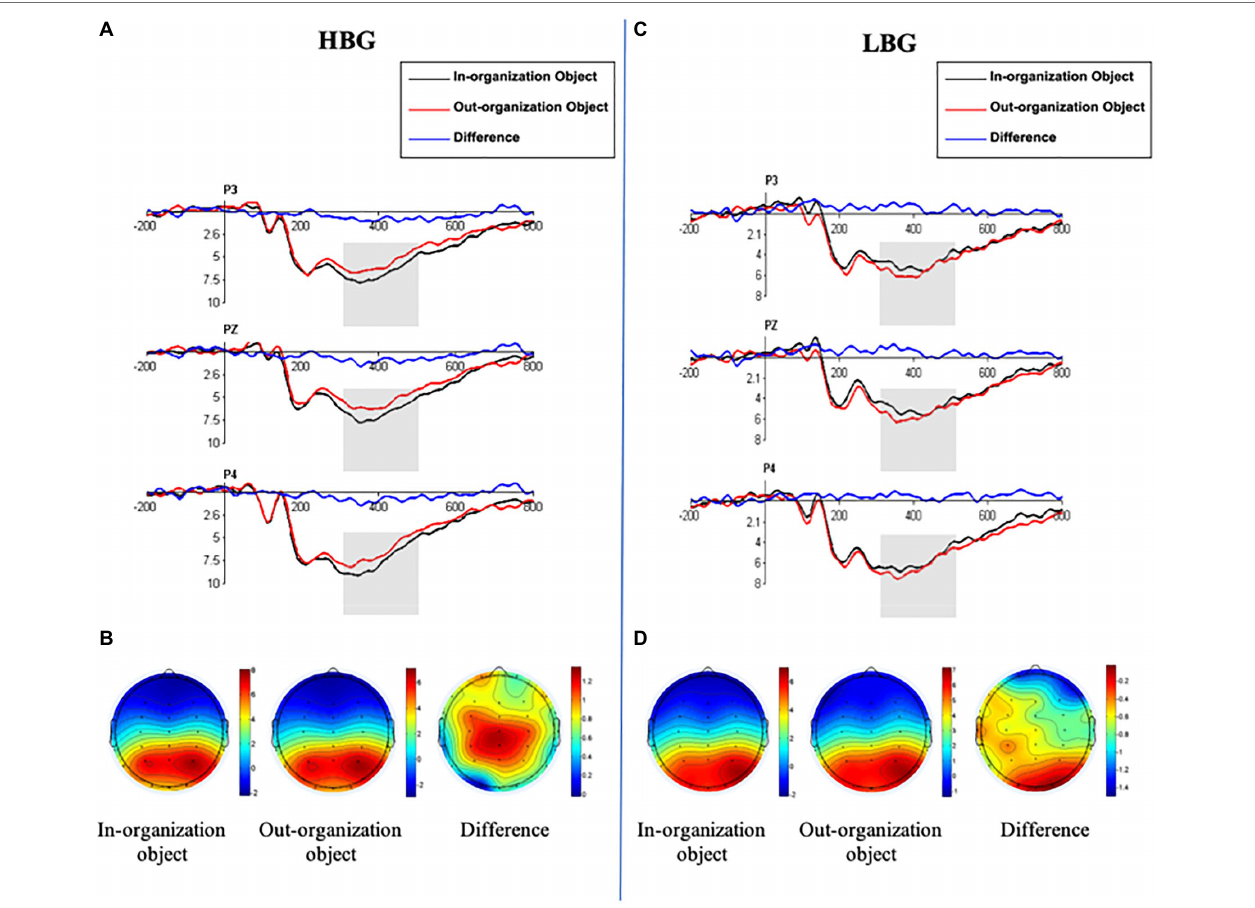
FIGURE 4 | Event-related potentials (ERP) results for Study 2. (A,C) The Grand mean of ERP waves computed at a set of frontal-central sites (P3, Pz, and P4) of subjects in the HBG (A) and in the LBG (C) . (B,D) Topographic voltage maps of mean amplitudes of P300 (300 ms–500 ms) for subjects in the HBG (B) and in the LBG (D)